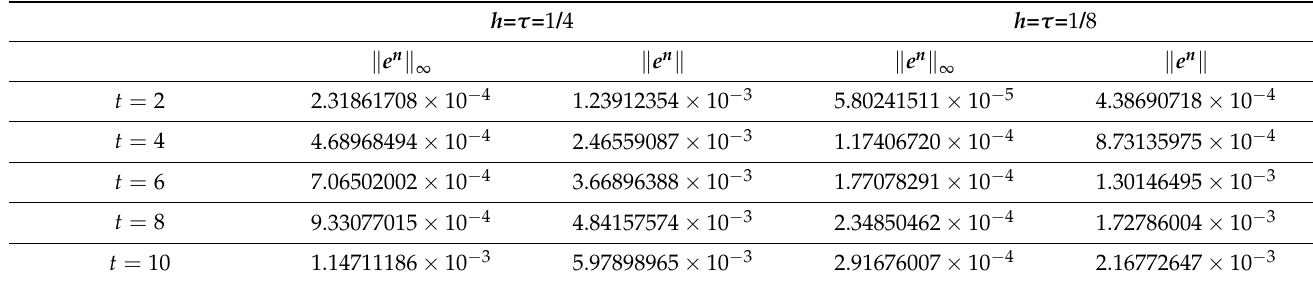
Table 1. The errors at different times with various h and τ .